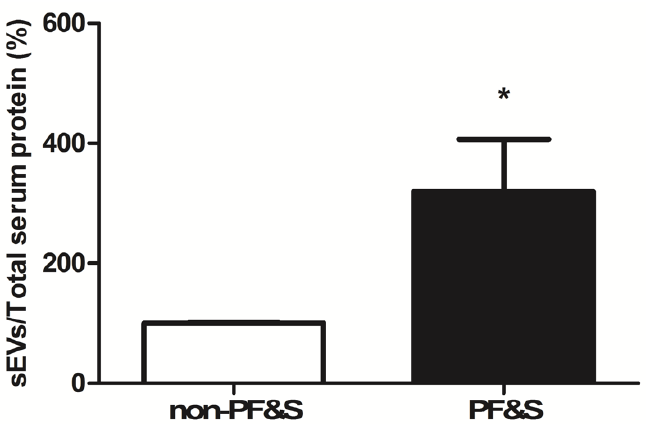
Figure 2. Serum levels of small extracellular vesicles (sEVs) in non-physically frail non-sarcopenic (non-PF&S) controls (n = 10) and participants with physical frailty and sarcopenia (PF&S; n = 11). Data were normalized for the amount of total serum proteins and are shown as percentage of the control group set at 100%. Bars represent mean values ( ± standard error of the mean). * p < 0.05 versus non- PF&S.